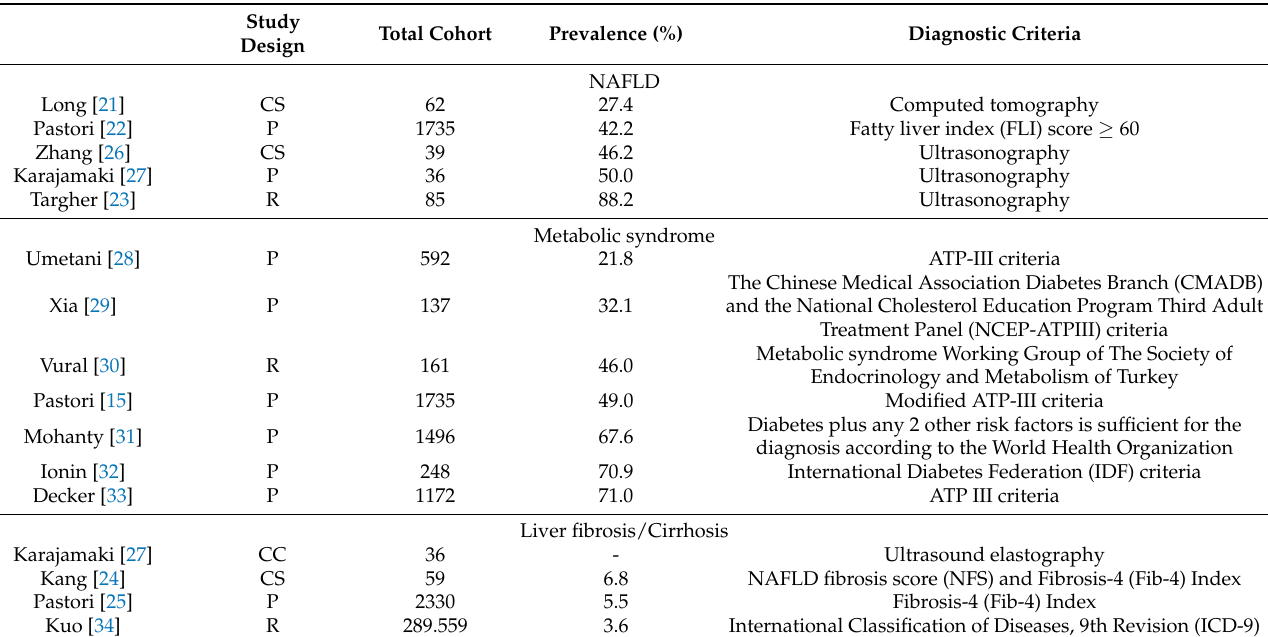
Table 1. Prevalence of liver fibrosis, non-alcoholic fatty liver disease (NAFLD) and metabolic syn- drome in patient with atrial